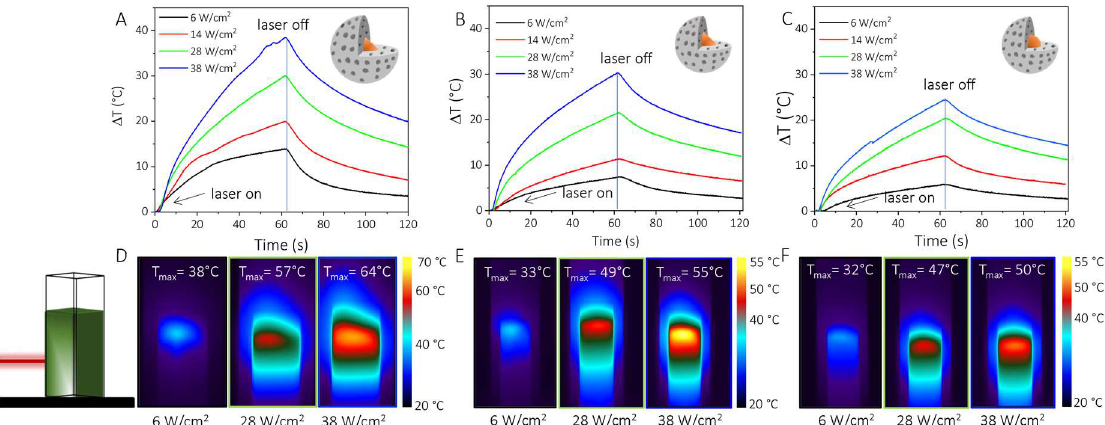
Figure 5. ( A – C ) Heating/cooling curves reporting the temperature increase versus time for NPL@MSS_05 ( A ), NPL@MSS_03 ( B ) NS@MSS_03 ( C ), irradiated by a CW laser light at 808 nm and 6 (black line) 14 (red line), 28 (green line) and 38 (blue line) W/cm 2 . The CW laser has been switched off after 60 s and the cooling rate was recorded, ( D–F ) pictures of the temperature distribu- tion inside the cuvette, mapped by thermal camera at laser off.